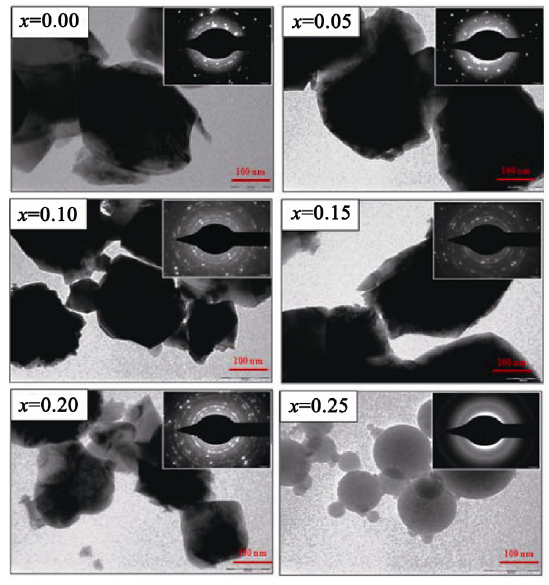
Fig. 4 TEM images of Mg 0.25– x Co x Cu 0.25 Zn 0.5 Fe 2 O 4 (0 ≤ x ≤ 0.25) ferrites.